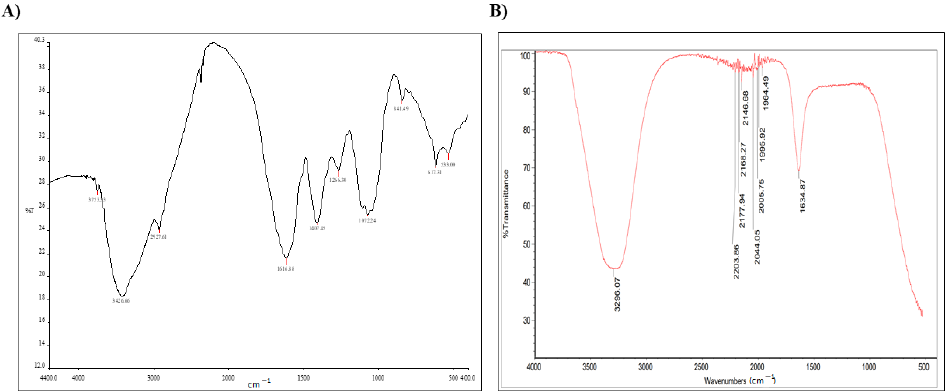
Figure 3. FT-IR results. The results were produced by Nicolet 6700 FT-IR Spectrometer at the range of 500–4000/cm. ( A ) A. factorovskyi extract, ( B ) AF-AgNPs.